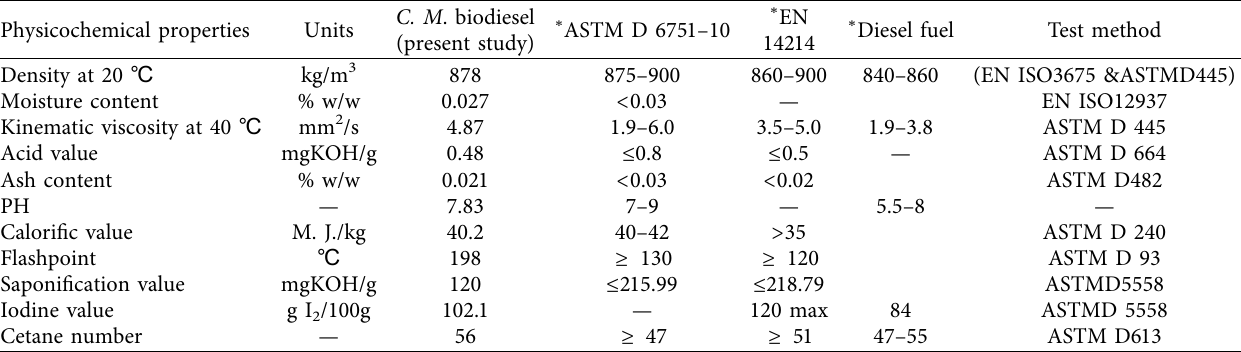
Figure 10: Te FTIR obtained for C. M . based biodiesel produced in this study. Table 4: Correlation of C. M. biodiesel with